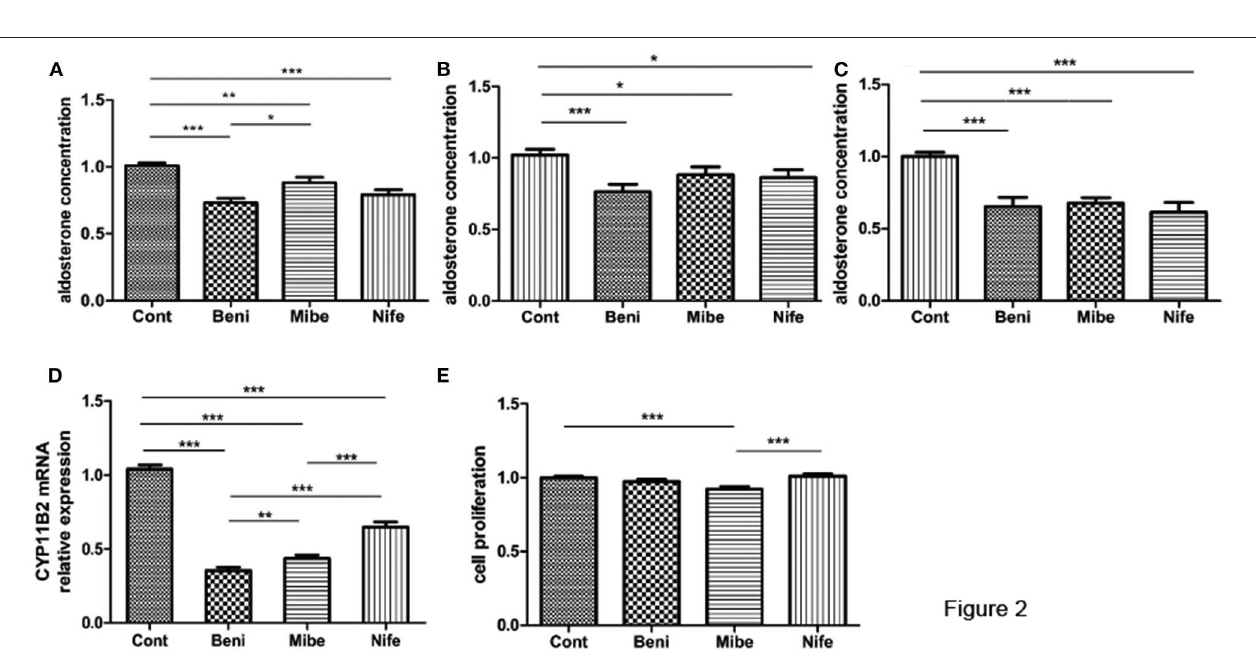
FIGURE 1 | The dose-effect of CCBs on aldosterone secretion in APA cells (mean ± SE, N = 3). Cont, control; Beni, benidipine; Mibe, mibefradil; Nife, nifedipine; X axis means different concentration of Benidipine, mibefradil and nifedipine. The unit is µ M. Aldosterone concentration in control group was set as 1. * P < 0.05; *** P < 0.001.